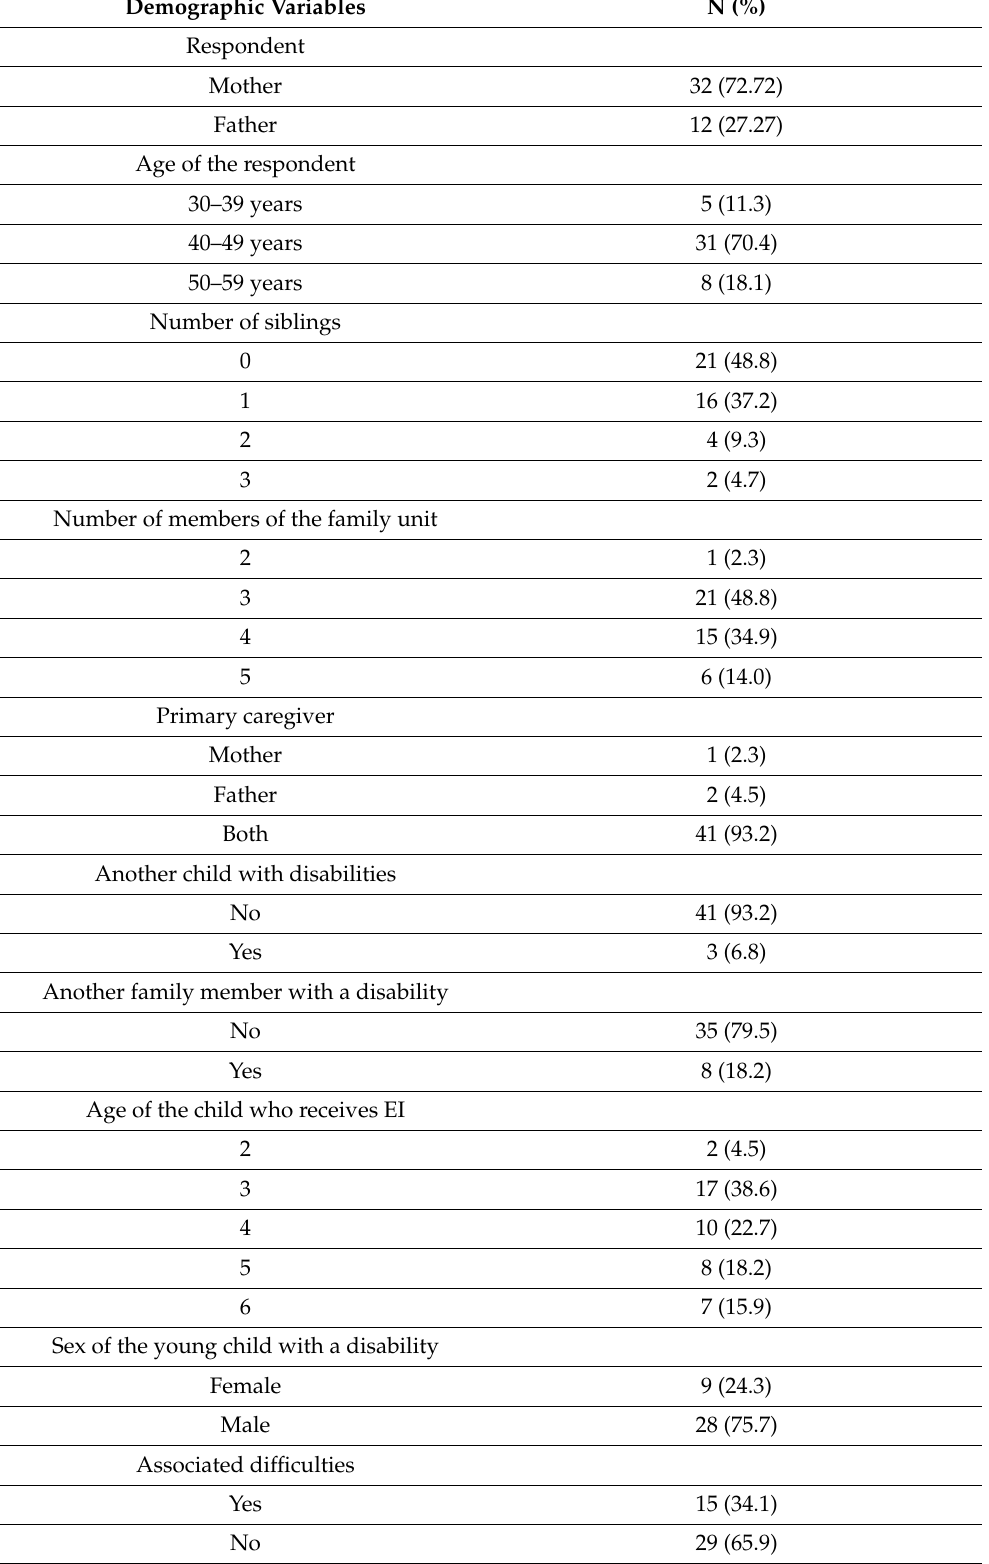
Table 1. Child and caregiver